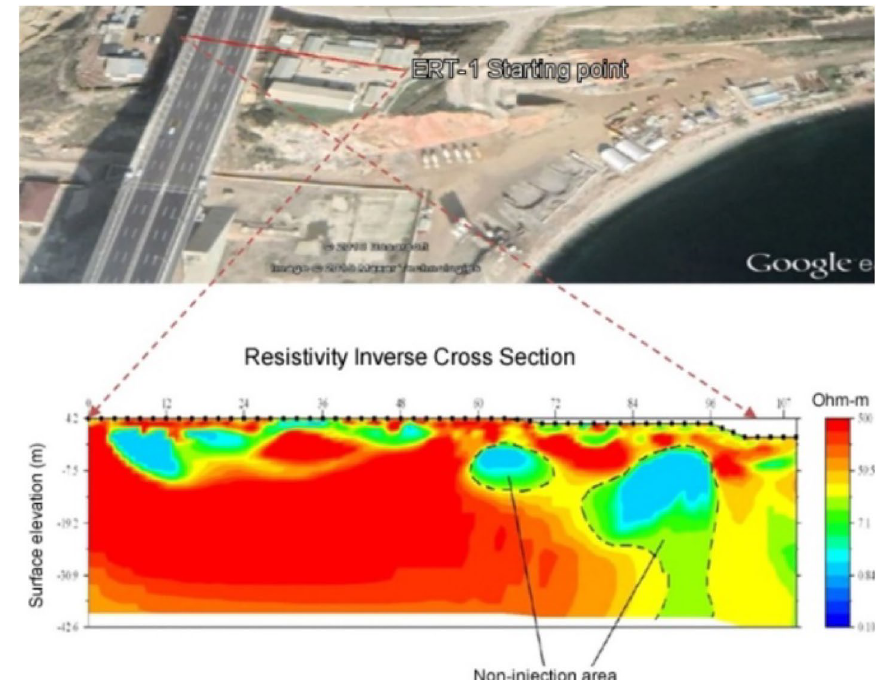
Fig. 11 ERT-1 Line Resistivity inversion section